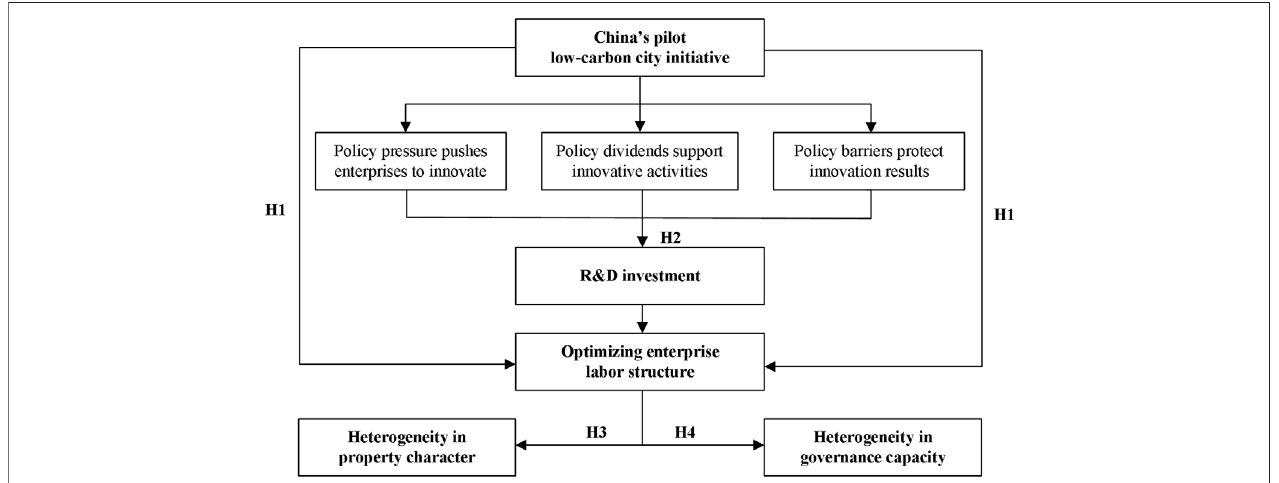
FIGURE 1 | Logical